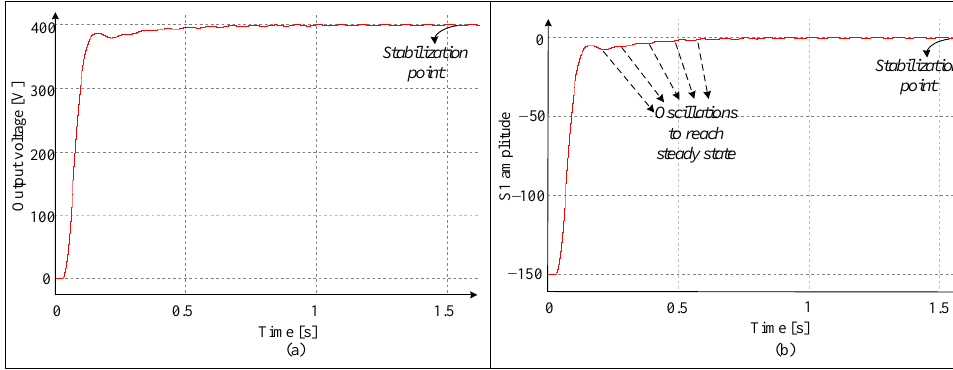
Figure 11. DC voltage behavior in start-up: ( a ) DC voltage; and ( b ) DC voltage error S 1 . The behavior of AC current in SBBC in start-up is presented in Figure 12. In Figure 12a, a transient with an over peak near 15 times the desired value is observed; nevertheless, the over peak is only presented for the first half cycle of the wave and the AC current rapidly stabilizes in a sinusoidal wave in the second grid cycle while zero crossing deformation is gradually reduced in four cycles. Figure 12b presents the behavior of AC current error ( S 2 ). Initially, S 2 also has a couple of large transient oscillations, and then the magnitude of oscillations is significantly reduced, being only evident for the first zero crossings. S 2 reaches the convergence zone oscillating near the equilibrium point in the adaptive hysteresis band. The main function of S 2 consists on properly following the AC current reference according to load requirements which permits avoiding the non-minimum phase behavior; in addition, another function of S 2 consists on performing PFC.